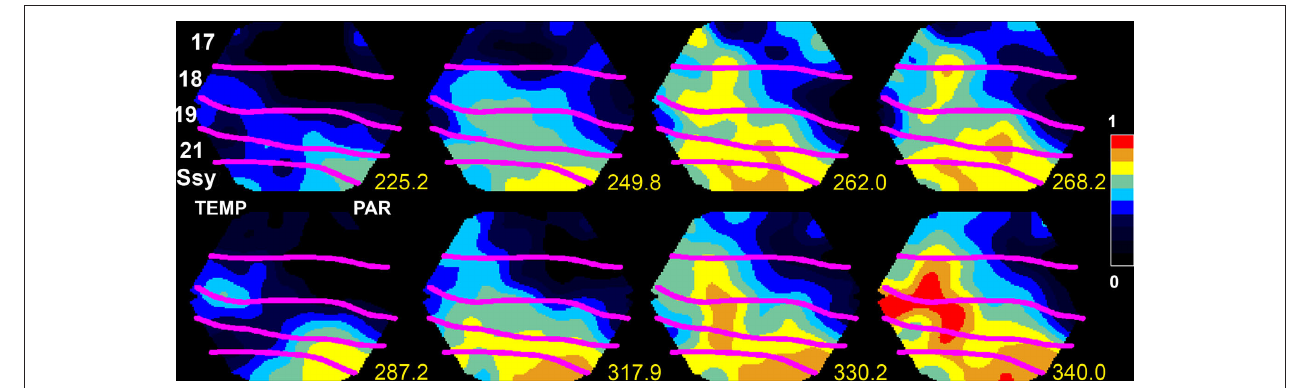
areas SSY, 21, 19, 18, and 17 of the ferret. The anatomically reconstructed cytoarchitectural borders shown in magenta overlaying the cortex. Scale: relative membrane potential in fraction of maximum. TEMP temporal lobe localization, PAR parietal lobe